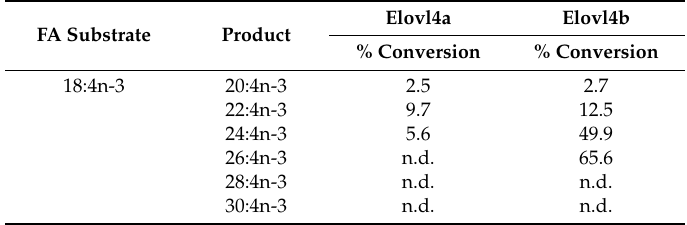
Table 3. Functional characterization of the Sparus aurata Elovl4a and Elovl4b elongases by heterologous expression in the yeast Saccharomyces cerevisiae